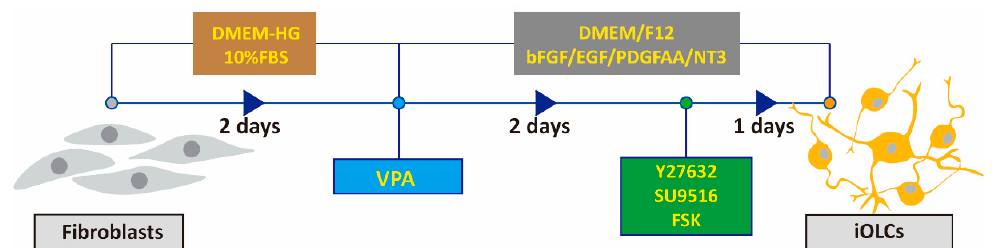
Figure 2. Sketch of iOLCs generation process. The flow chart shows Y27632, SU9516, and FSK treatment with induction medium one day after VPA pre-treatment and after two days of treatment that converted fibroblasts into iOLCs.